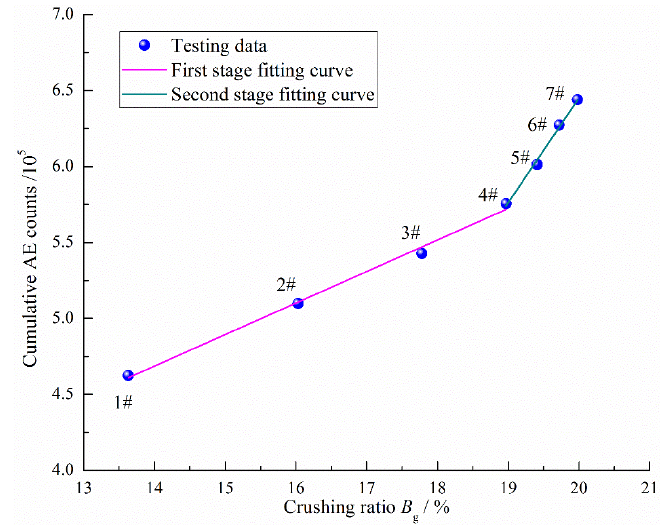
Figure 10. The evolution characteristics of cumulative AE counts under the CACL experiment.